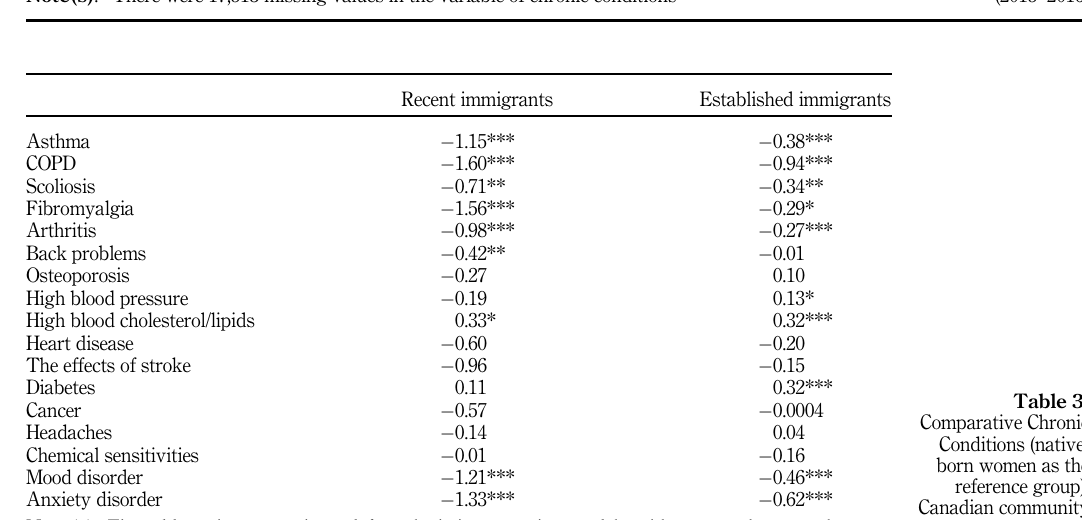
Table 3. Comparative